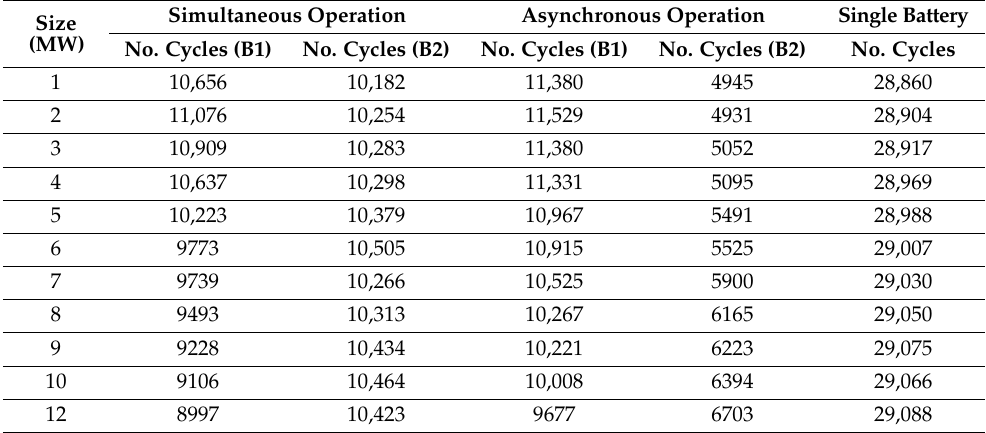
Table 3. The number of charge/discharge cycles for each battery under different operating